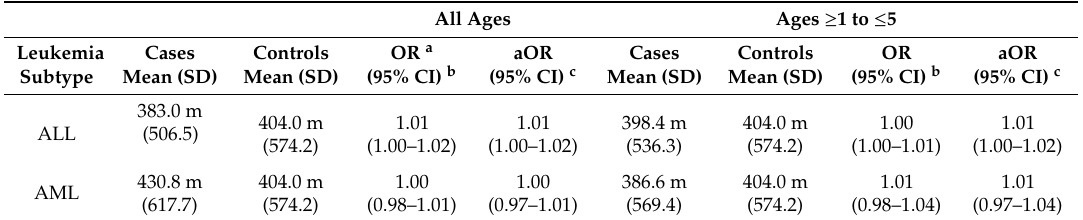
Table 2. Associations between continuous distance of maternal residence to nearest major roadway and leukemia in o ff spring.